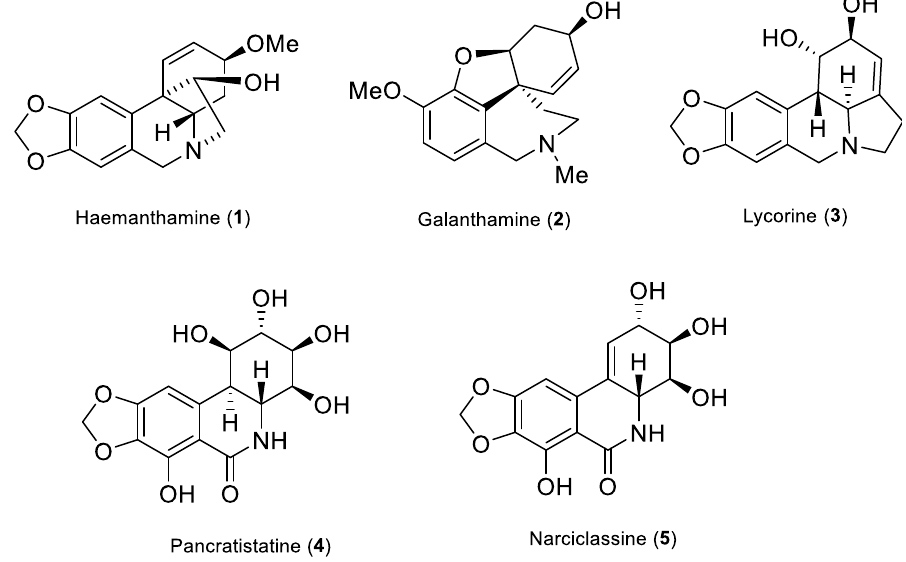
Figure 1. Structures of selected bioactive Amaryllidaceae alkaloids.